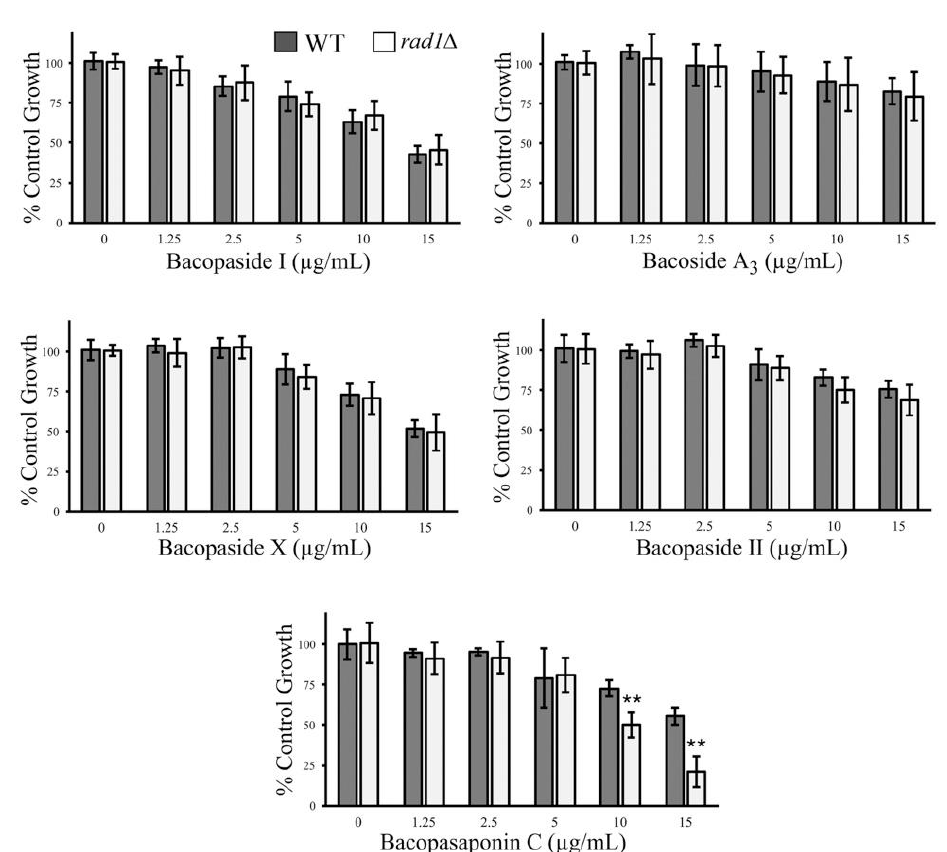
Figure 10. Bacopasaponin C exhibits chemical-genetic interactions with RAD1 . Five of the major constituents of B. monnieri extracts were examined for synthetic lethal interactions with yeast deleted for RAD1 . Strains utilized were WT (BY4742) and rad1 ∆ (12806). Strains were grown in synthetic medium with 2% glucose in the presence of vehicle (2% DMSO and 0.2% Tween 80), bacopaside I, bacoside A3, bacopaside X, bacopaside II, or bacopasaponin C at the indicated concentrations. Growth was monitored by measuring OD at 600 nm with vehicle control (0) set at 100%. Values are mean ± SD ( n = 3). Statistical analysis employed Student’s t -test ** p < 0.01.